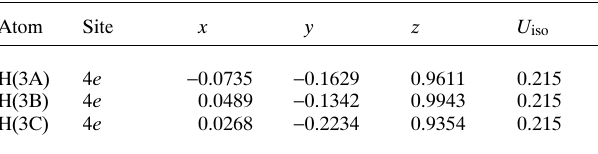
Table 2. Atomic coordinates and displacement parameters (in Å 2 )